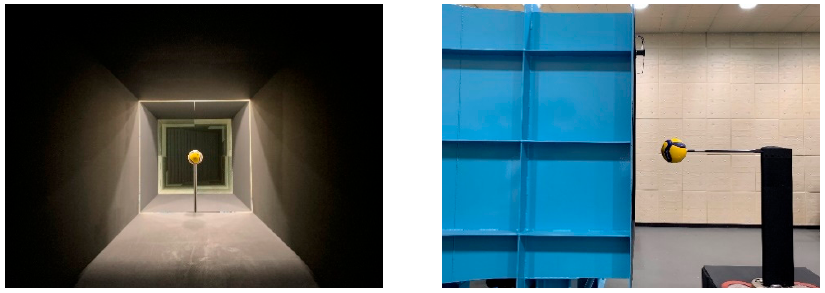
Figure 1. Wind tunnel setup.